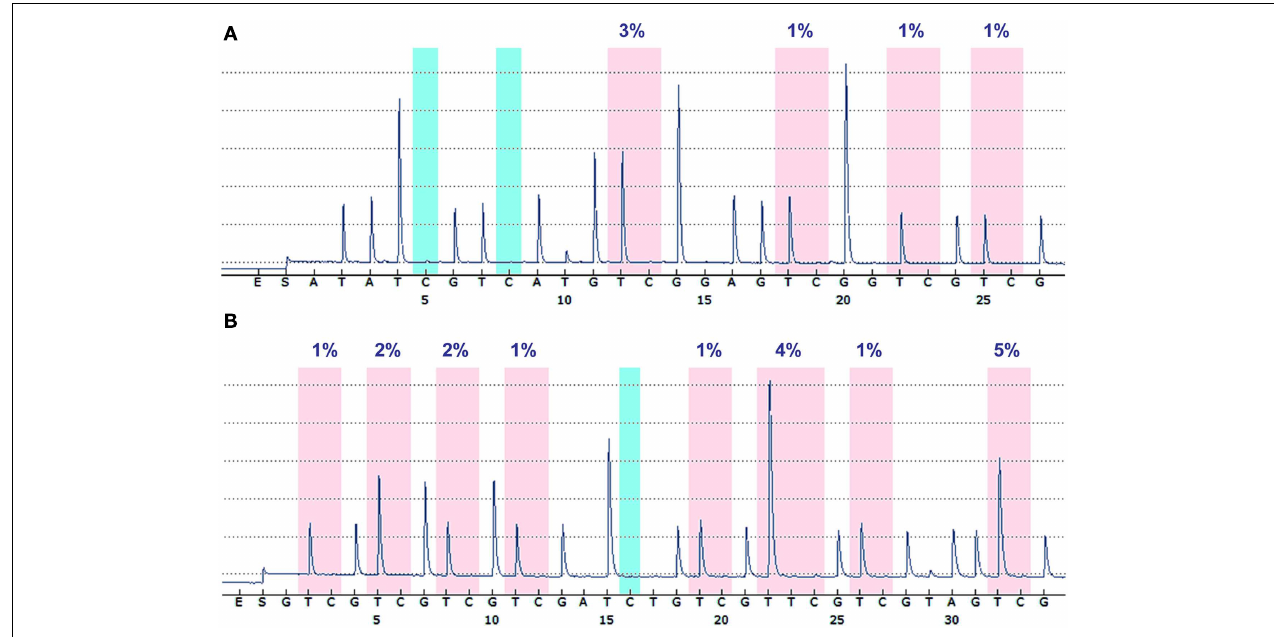
FIGURE 2 | Representative pyrograms. Typical pyrograms obtained from patient samples for IDH1 (A) and IDH2 (B). Each pink shaded column indicates a CpG dinucleotide assayed, and the percentage of methylation at that CpG dinucleotide is indicated above.The blue shaded boxes are internal bisulfite modification control